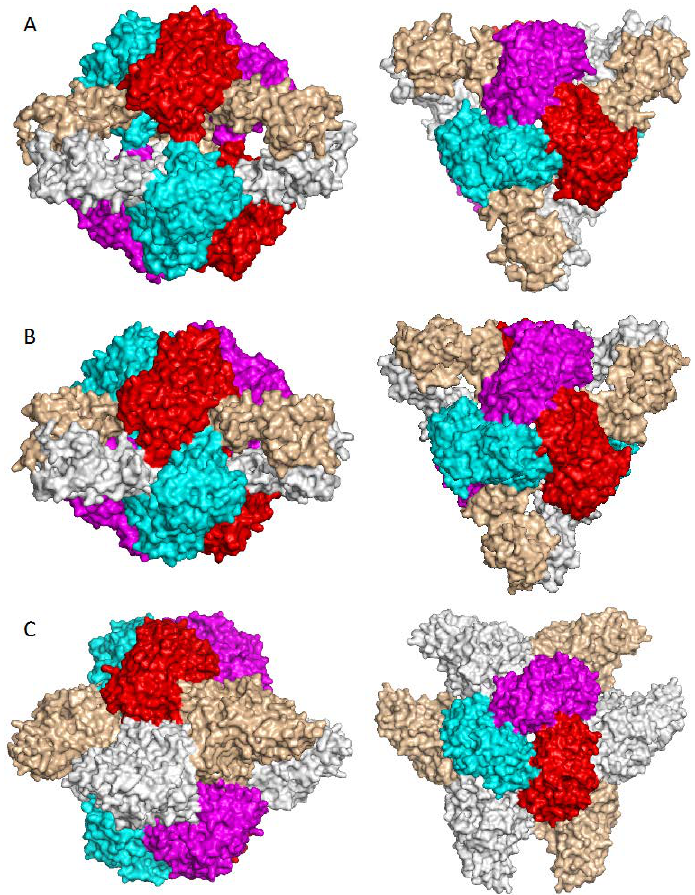
Figure 8. Higher oligomeric structure of ATCase. ( A ) R-state of Escherichia coli ATCase showing the dodecameric structure with two catalytic trimers (shown in red, magenta and cyan) at the top and bottom, and three regulatory dimers (shown in grey and tints) in the equator; ( B ) T-state of E. coli ATCase; ( C ) Structure of Aquifex aeolicus ATCase in complex with dehydroorotase. Two catalytic trimers located at the top and bottom are completely separated by three dehydroorotase dimers in the middle. Left : viewed perpendicular to three-fold axis; right : viewed down 3-fold